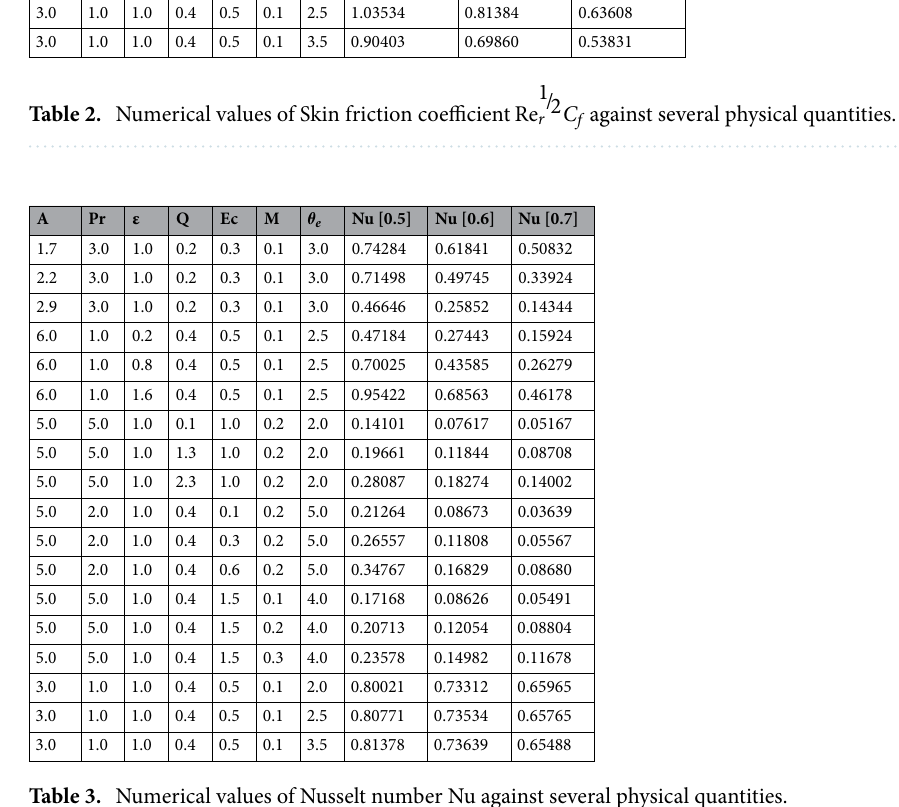
Table 3. Numerical values of Nusselt number Nu against several physical local dynamic pressure, 1 2 ρ U 2 , that is felt as shear stress on the surface. Table 2 shows that value of skin friction parameter decreases when we increase the value of A and θ e whereas skin friction parameter increases when we increase the value of ε , Q , Ec and M . Table 3 highlighted the impact of A , ε , Q , Ec , M and θ e on (Nu). In fluid dynamics, the nusselt number is defined as the ratio of convective heat transfer to conductive heat transfer across a boundary in a fluid. Convection comprises of both diffusion (conduction) and advection (motion of fluid). When Nu = 1, it means that the heat transfer by pure conduction or we can say that fluid is stationary. The value of nusselt number between 1 & 10 is a feature of laminar flow or slug flow. The greater value of nusselt number corresponds to more active convection, with turbulent flow usually in the 100- 1000 range. It is noticed that an increment in magnitude of A decays nusselt number while a direct trend is noticed for ε , Q , Ec , M and θ e .